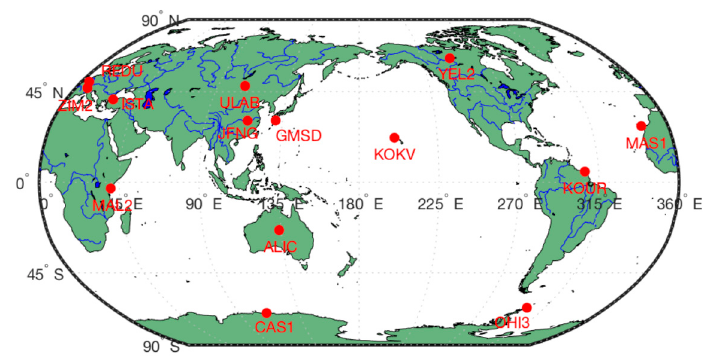
Figure 2. Distribution of selected IGS multi-GNSS stations.